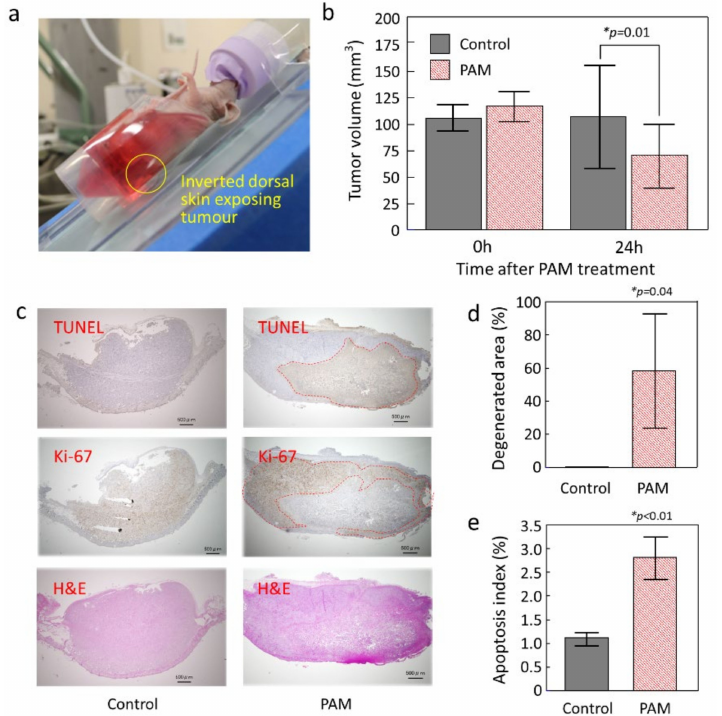
Figure 4. Induction of apoptosis in a 3D cancer tumour by PAM. ( a ) Photograph of a mouse with a bladder cancer tumour immersed in a bath of PAM. ( b ) Graph of the tumour volume before and after PAM treatment. ( c ) Typical histology images of tumour sections stained with TUNEL, Ki-67 for media control and PAM treated tumours. ( d ) Percentage of the degenerated tumour area. ( e ) Apoptosis index in the tumour. Control in all figures refers to cells exposed to untreated